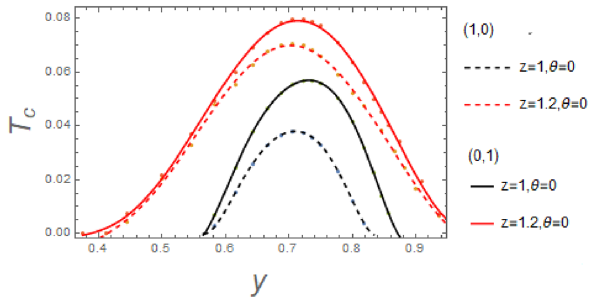
Fig. 4 Phase diagram on the temperature-doping plane with different θ and fixed z = 1. In this figure, solid lines are for ( q and dashed lines are for ( q A , q B ) = ( 0 , 1 ) . Black and red θ = 0 , 0 . 1, respectively. The critical temperature decreases as θ increases